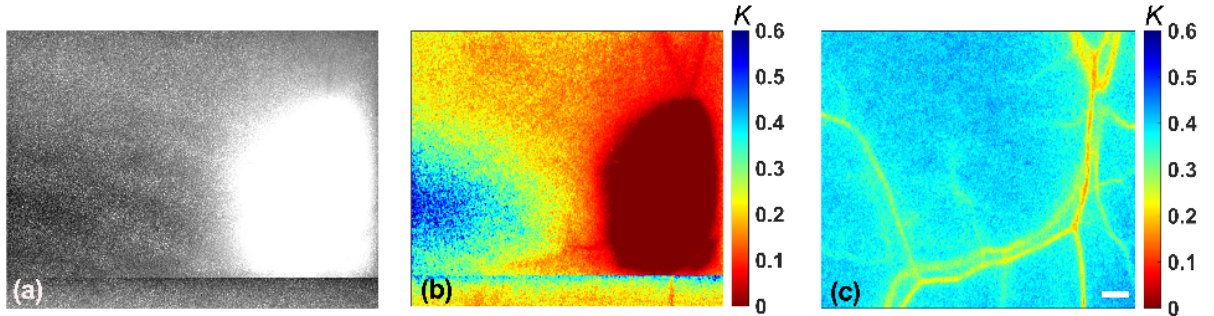
Figure 3. The elimination of overexposure by the band-pass filter (scale bar = 100 µm, K is the spatial contrast). ( a ) Raw speckle image, ( b ) contrast image without filtering, ( c ) contrast image with filtering.